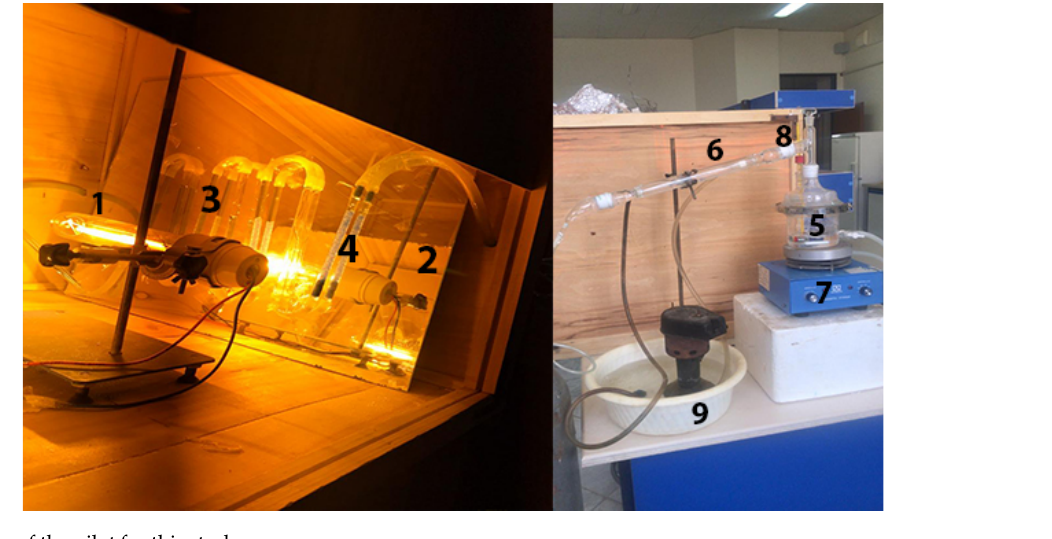
Figure 2. Plan of the pilot for this study 1) Light, 2) Mirror, 3) Photoreactor, 4) N,S-TiO coated on SSA glass MS, 5) Reactor containing 1-naphthol solution, 6) Condenser, 7) 2 Magnetic stirrer, 8) Thermometer, 9) Chiller pump and cold water chamber